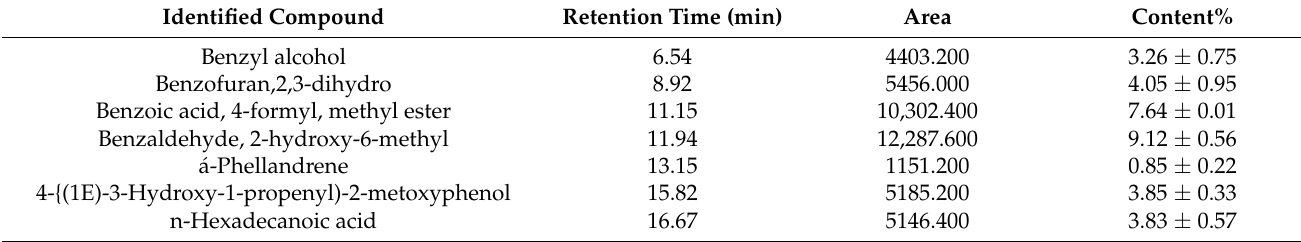
Table 7. The tentative identification of the main compounds in S. vulgaris leaves extract by GC-MS analysis.